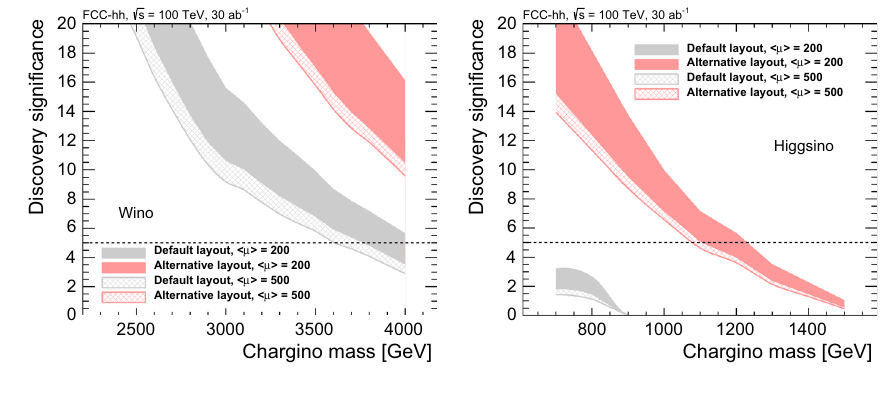
Fig. S.4 Expected discovery significance for higgsino and wino DM candidates at FCC-hh, with 500 pile-up collisions. The black and red bands show the significance using different layouts for the pixel tracker, as discussed in volume 3. The bands’ width represents the difference between two models for the soft QCD